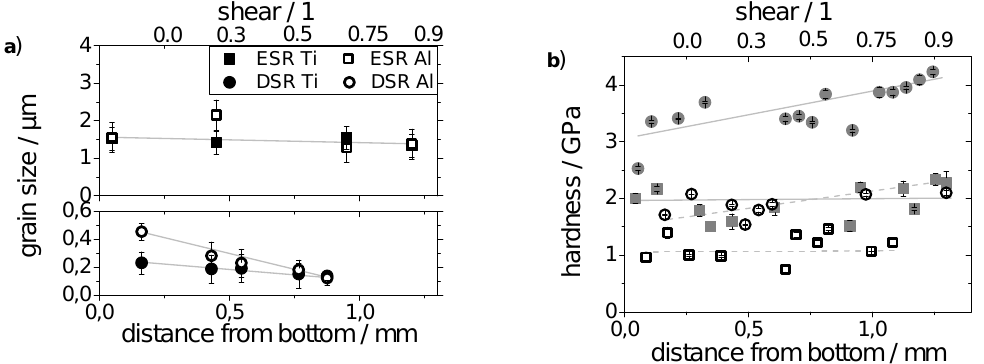
Figure 11. Grain size ( a ) and hardness ( b ) of a 160-layered Ti/Al composite subjected to three passes of conventional rolling (ESR) or differential speed rolling (DSR). The values are taken along the thickness of the sheet and, thus, reflect the amount of shear introduced into the